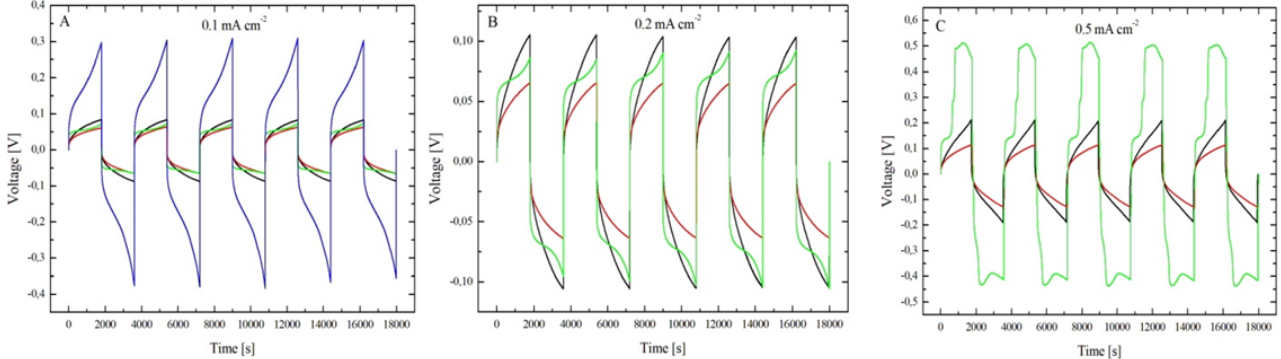
Figure 13. Chronopotentiometric transient shapes are highlighted from the datasets in Figure 12. Eutectic electrolytes based on hydrated electrolytes are found to yield the longest- living cells. With ChU0.3 (red plots in Figure 12), all cells responding with a voltage excursion of ca. ± 70 mV cycled at 0.1 and 0.2 mA cm −2 (Figure 12 Panels A and B, respectively) and were still running after 75 days. The chronopotentiometric transients remained stable from the beginning to the end of the test. Again, with ChU0.3, cells cycled at 0.5 and 1 mA cm −2 , giving rise to voltage responses of ca. ± 120 and ± 300 mV (Figure 12, red plot, Panels C and D, respectively), and were terminated by a short circuit after 58 ± 7 and 7 ± 4 days, respectively (time between the start and the first short circuit). Cell termination occurred from a short circuit within two charge-discharge periods (2 h), exhibiting the irregular voltage behavior highlighted in Figure 12, Panels C and D. Instead, the coin cells containing ChU0.1 (a urea-eutectic electrolyte with 0.1 M ZnSO 4 and, therefore, lower hydration level; black plots in Figure 12) show an extension of the period in which the voltage response of the cell has regular behavior. In fact, a short circuit occurs after 33 ± 29 and 3 ± 2 days of cycling at 0.2 and 0.5 mA cm −2 , respectively. Similar to what we observed for ChU0.3 and ChU0.1, the shape of the transient remains regular and stable (Figure 12 Panels A–D, black plot) until a short circuit occurs after a couple of irregular cycles (see plot in Figure 12). At 1 mA cm −2 , the cycles are characterized by square transients of ± 50 mV from the beginning of the test (Figure 12 Panel D), suggesting ohmic control, possibly due to the presence of a passivation layer, which is, however, fully recovered after a few transients. The fact that the chronopotentiometric transients remain regular until cell failure for the systems analyzed implies a reversible plating/stripping process, as suggested by [47]; If compared with similar experiments in an aqueous solution [47], this indicates that urea-based systems are indeed very promising in view of the stable cycling of Zn anodes. Zn cycling stability is further witnessed by the fact that none of the investigated cells fails by passivation, which is the dominating failure mode for Zn aqueous cells [46,47]. The reason for Zn’s cycling behavior lies in the fact that, in the DESs considered in this study, a small percentage of water has very low activity because of its coordination function when water enters the lattice through hydrogen bonds [2,48]. Indeed, due to its bipolar nature, water molecules can act either as HBD or HBA. Specifically, when water is present in a small amount (< 5 w/o or < 30 mol.%), it is absorbed in the molecular matrix of DES by forming H-bonds with the ions and HBDs. Zhekenov et al. [48] observed similar behavior for different DESs, considering the number of hydrogen bonds forming in water-containing pairs: HBD–water, choline ion–water and chloride ion–water. Of course, all these interactions increase with increasing water content, and the HBD–water pair demonstrates the most significant change with the formation of a high number of hydrogen bonds as water is added into the system; this is also reflected in the high solubility of the components in water. Furthermore, the other component pairs (i.e., HBD–choline ion, HBD–chloride ion and HBD–HBD) have a descending trend in molecular interactions with the addition of water for all DESs. A decrease in these interactions reflects the preference of HBD to form